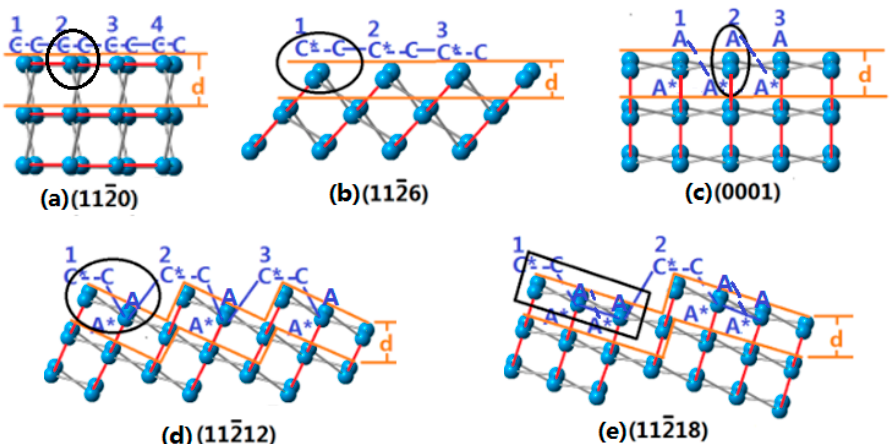
Figure 9. Atomic structures and types of surface atoms of basic crystal planes in Part A: ( a ) (1 1 − 2 0) plane; ( b ) (1 1 − 2 6) plane; ( c ) (0 0 0 1) plane; ( d ) (1 1 − 2 12) plane; ( e ) (1 1 − 2 18) plane.